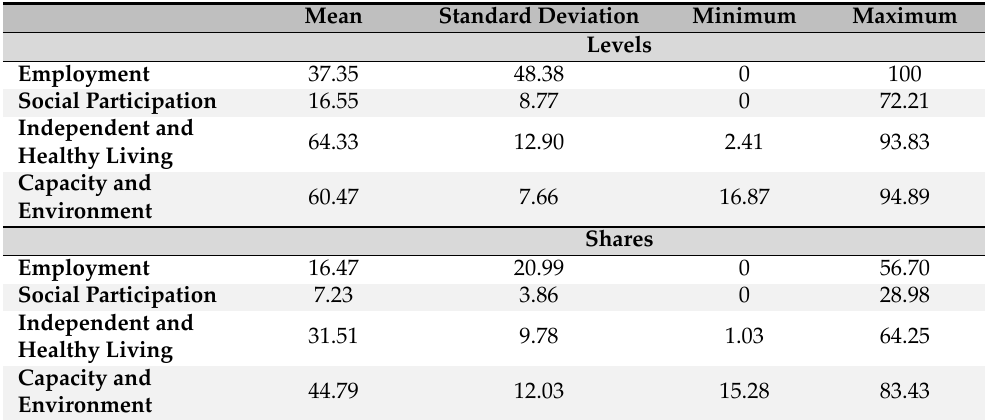
Table 5. Individual Components of the Healthy and Active Ageing Index in